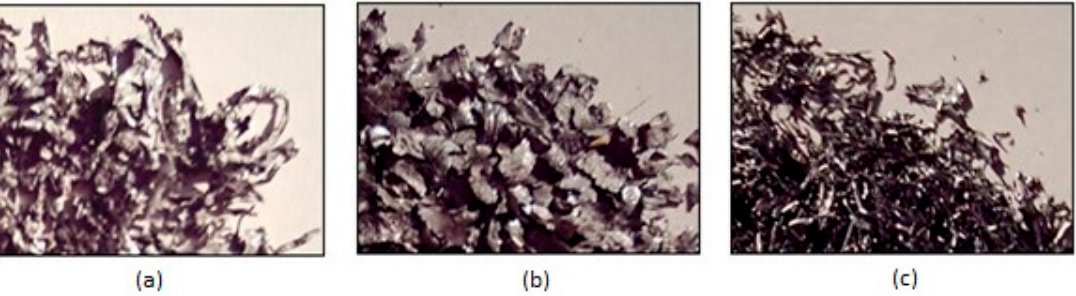
Figure 3. The drawing force recorded for a sample, drawn through a die with the deformation angle 2· α = 10°.